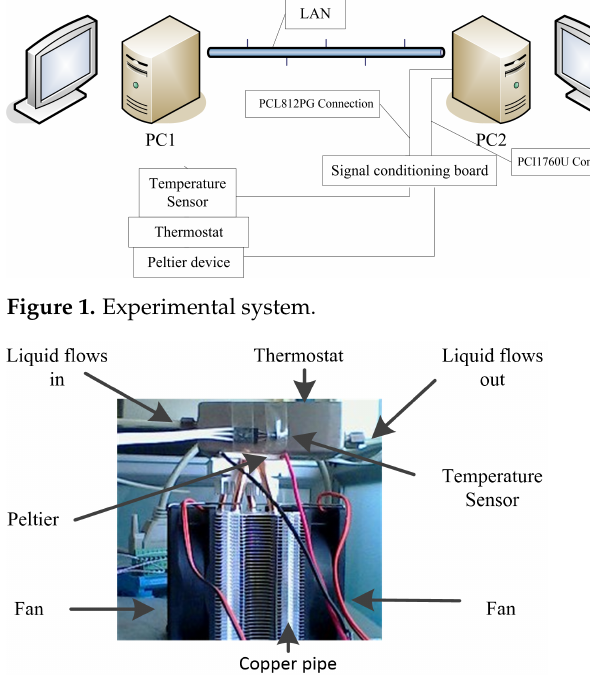
Figure 2. Thermostat system.